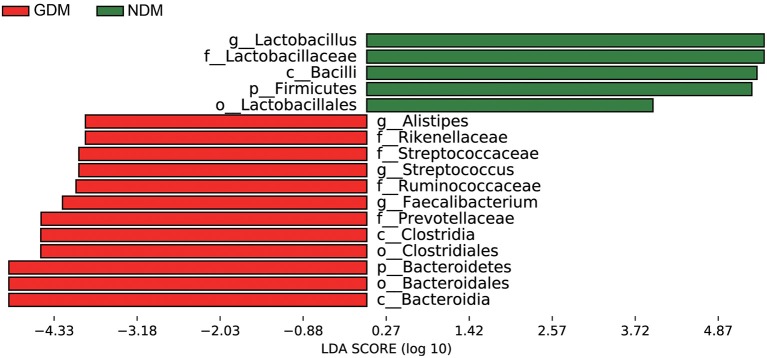
LEfSe analysis of oral microbiota in neonates born to mothers with and without gestational diabetes mellitus. Histogram of the LDA scores generated by LEfSe indicating differences at phylum, class, order, family, and genus levels between the two groups, the prefixes “p,” “c,” “o,” “f,” “g” represent the annotated level of phylum, class, order, family and genus.